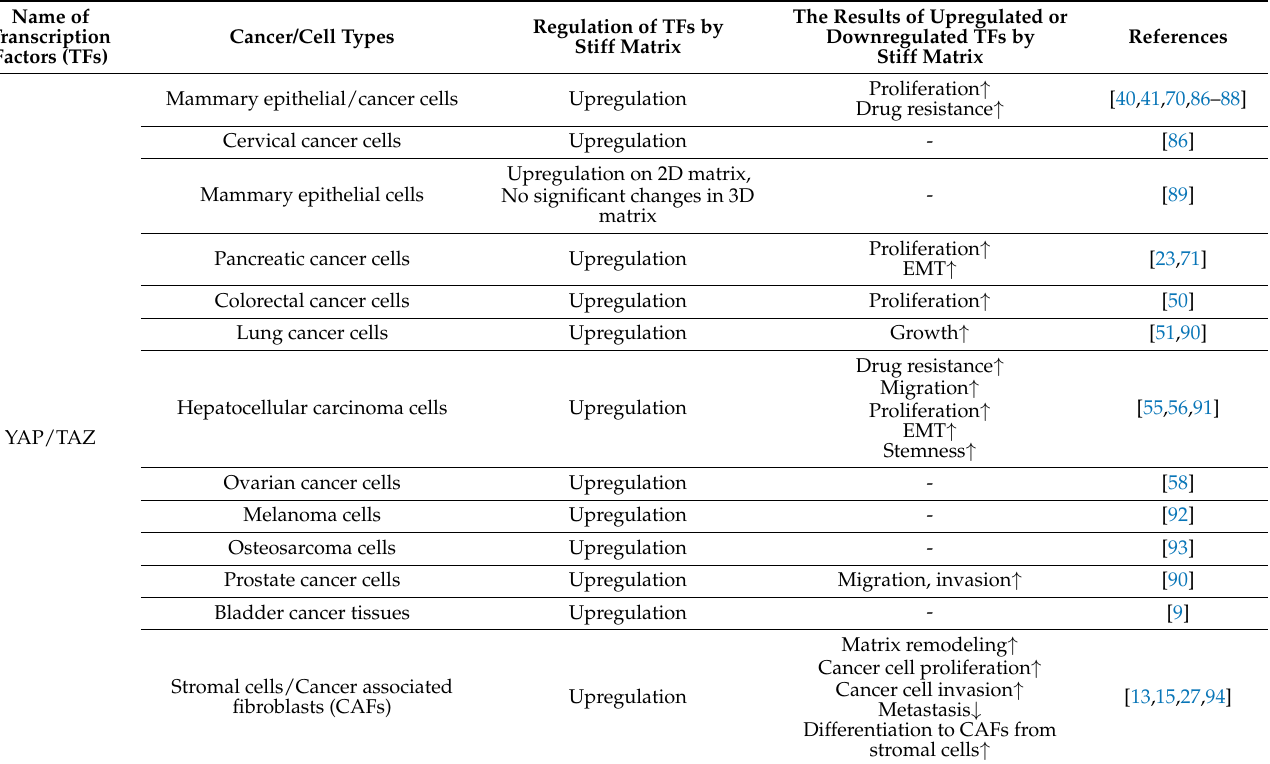
Table 1. Transcription factors regulated by matrix stiffness in